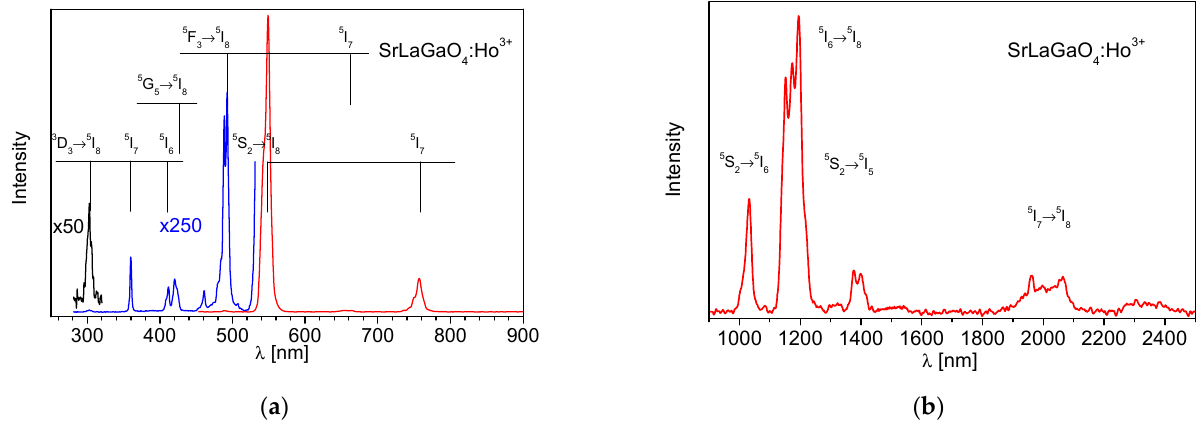
Figure 4. ( a ) UV-Vis and ( b ) IR part of polarized emission spectrum of SrLaGaO 4 : Ho 3+ recorded at room temperature.